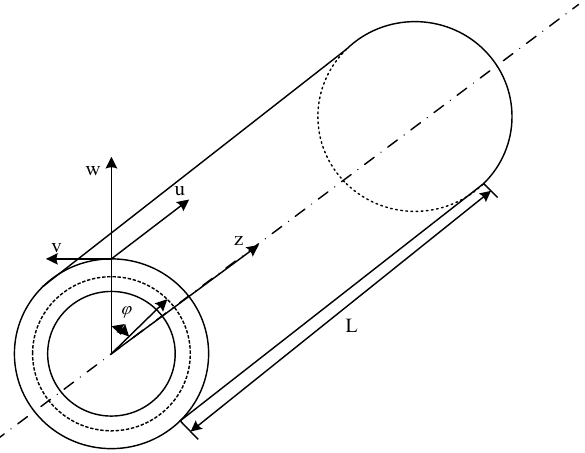
Figure 1: Schematic diagram of the cylindrical